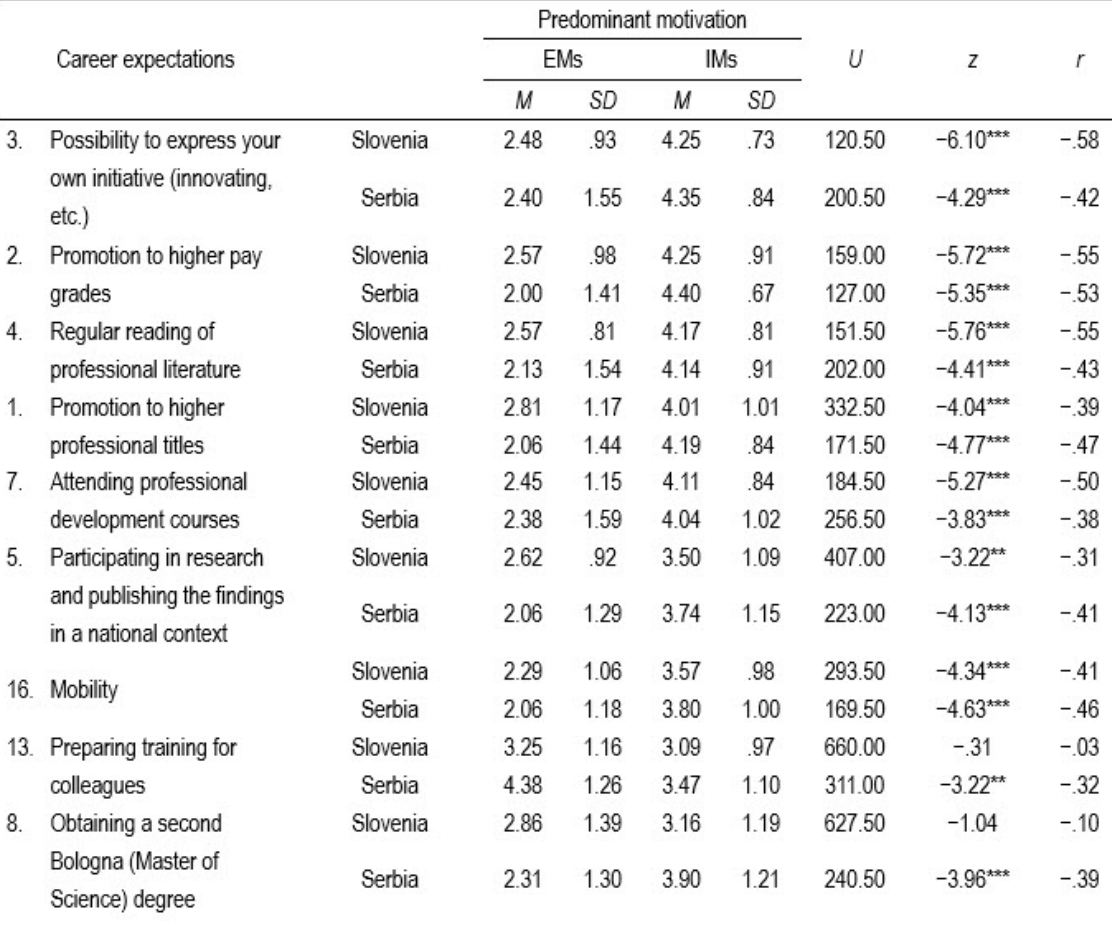
Means, standard deviations, and Mann-Whitney test for individual items of the Career Expectations